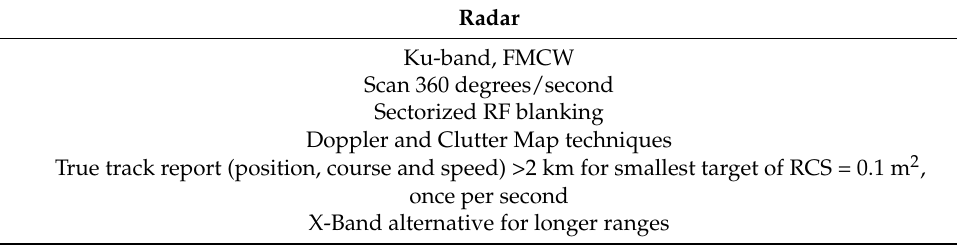
Table 2. ARMS radar specifications.